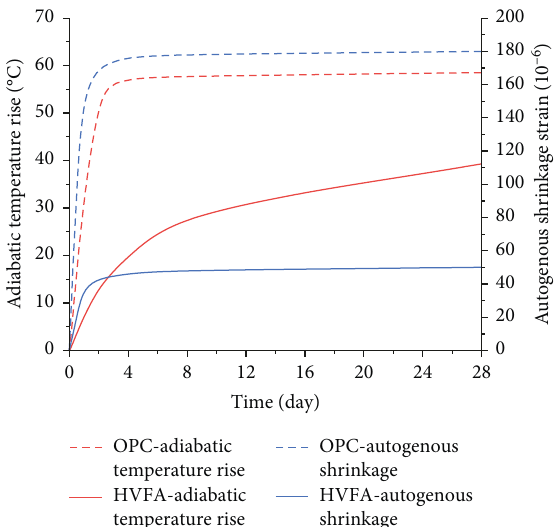
Figure 1: Adiabatic temperature rise and autogenous shrinkage strain development with